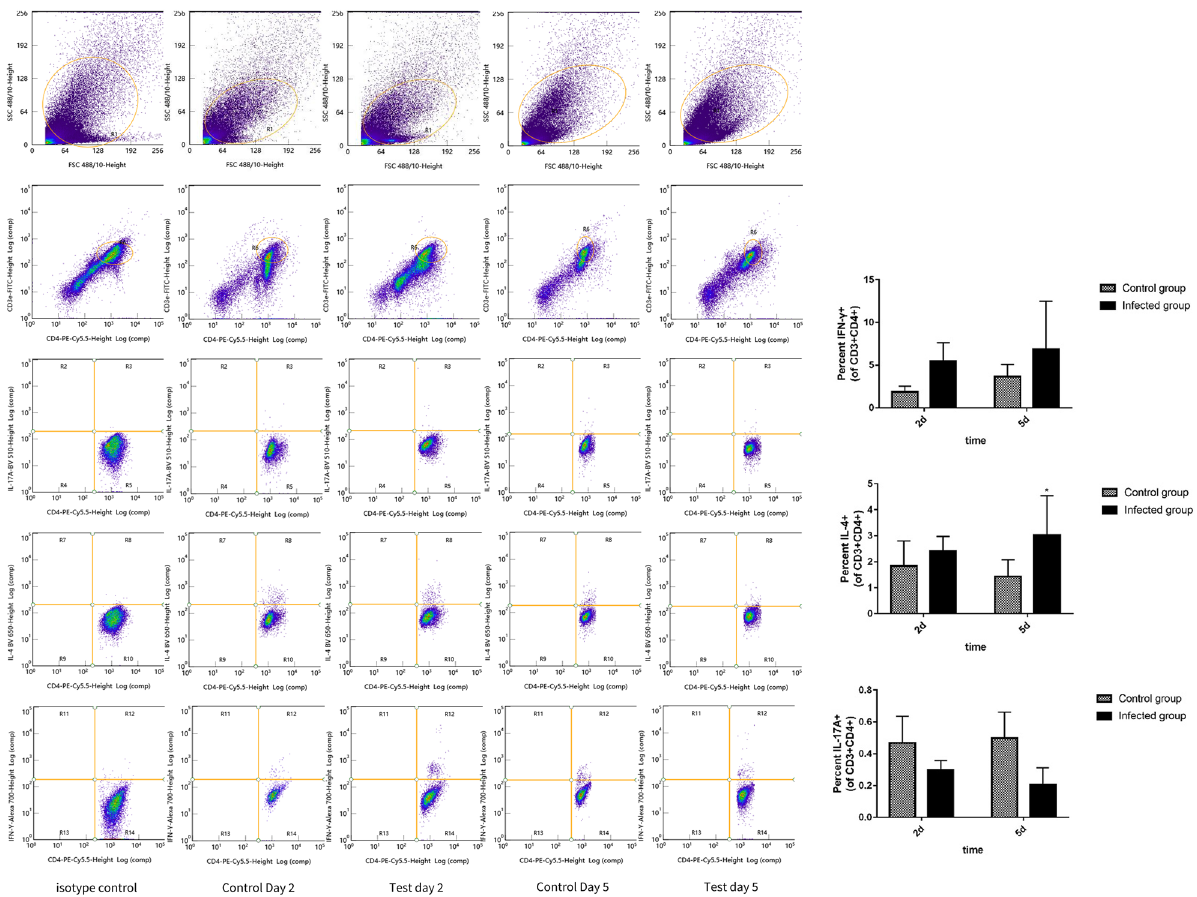
Figure 6. Cladosporium cladosporioides induced more Th1 and Th2 cells after infection. We detected Th cells (Th1, Th2, and Th17) with the antibodies IFN-γ, IL-4, and IL-17A, respectively. More Th1 and Th2 cells differentiated after infection. Data are expressed as mean ± SEM (n = 6 mice per group).* p < 0.05; ** p < 0.01; *** p <